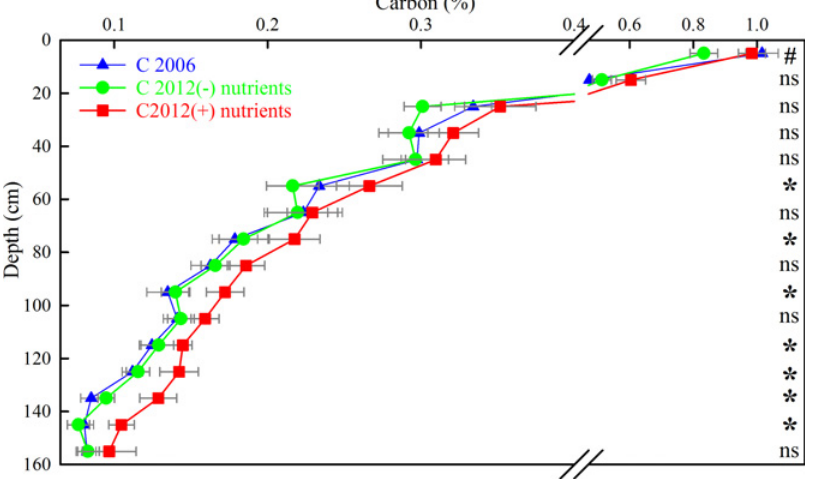
doi:10.1371/journal.pone.0153698.g002